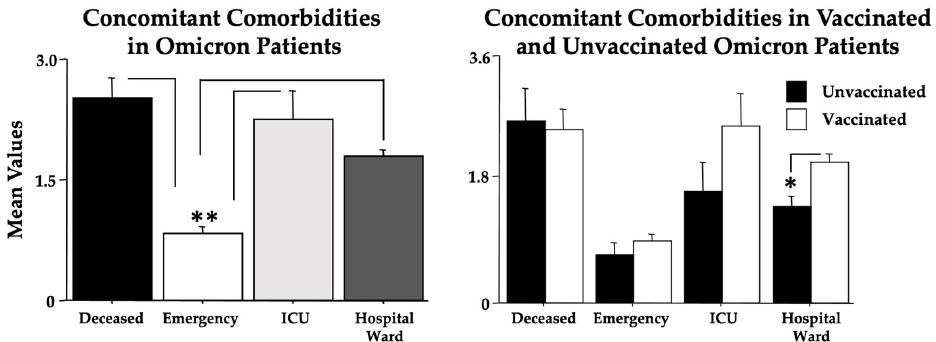
Figure 1. Concomitant comorbidities of the recruited individuals ( left panel ) with or without vaccination ( right panel ). The error bars indicate pooled standard error means (SEM) derived from the appropriate error mean square in the ANOVA. The asterisks (** p < 0.01; * p < 0.05) indicate post hoc differences between groups.